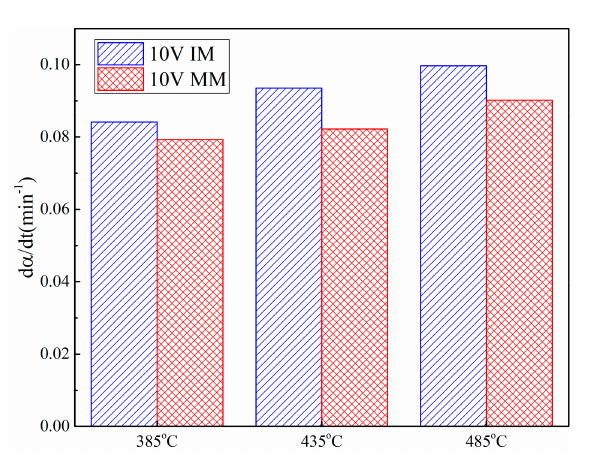
Figure 10. The conversion rate of 10V IM and 10V MM at different reaction temperatures.